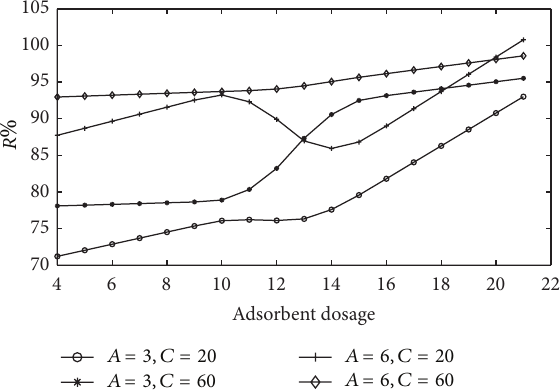
Figure 4: The effect of adsorbent dosage (g/L) on Cu(II) removal.